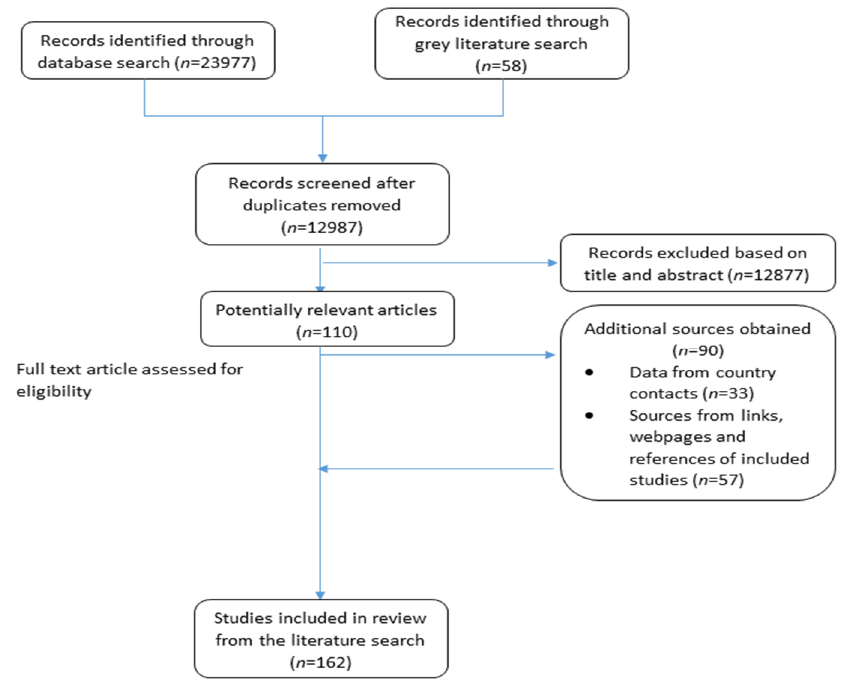
Figure 1. Search and identification process of potential references from the literature.